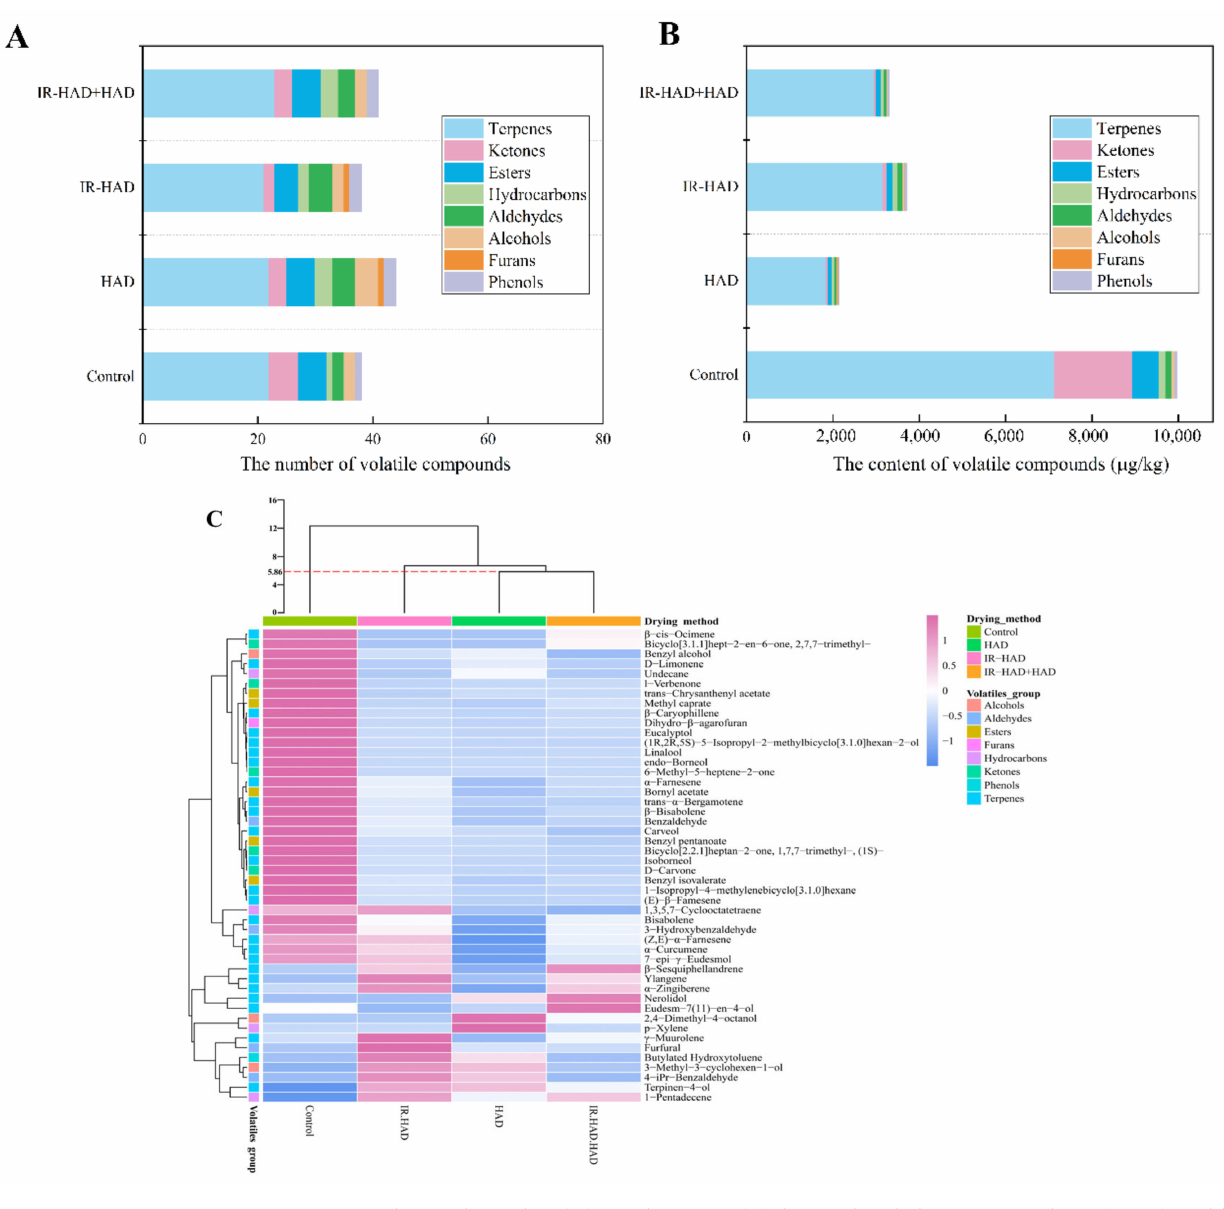
Figure 6. The total number ( A ), total content ( B ), hierarchical clustering analysis (HCA) and heat map ( C ) of 48 volatiles detected in chrysanthemum cakes dried by different methods: Control: freeze-drying; HAD, hot air drying at 65 ◦ C, IR-HAD, combined infrared and hot air drying at 65 ◦ C, IR-HAD + HAD, sequential IR-HAD and HAD at 65 ◦